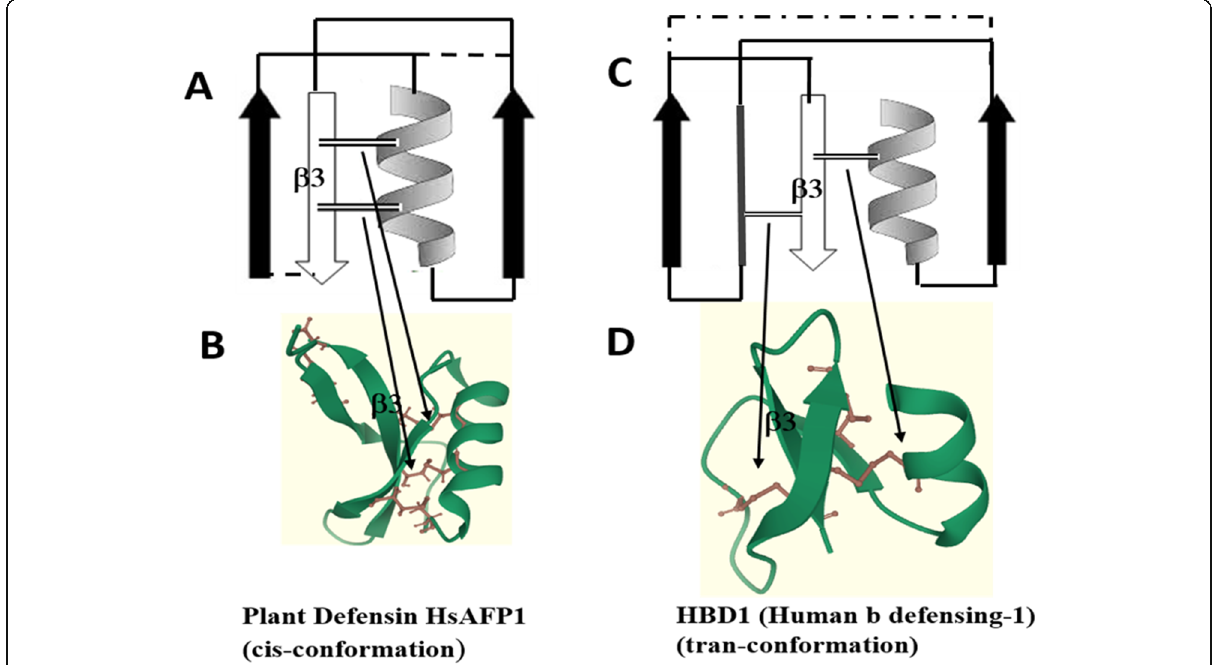
Fig. 2 Representative cis and trans conformation and corresponding tertiary structure of plant defensin HsAFP1 (cis) and human defensin HBD1 (trans). ( a and b ) Representative and tertiary structure of HsAFP1 (cis) and ( c and d ). For HBD1 (trans). In cis representative structure of HsAFP1, two consecutive conserved disulfides formed between a-helix and b-3 strand whereas in trans, these two conserved disulfide link form between a-helix and b-3 and b-3 and other secondary structure. --dash line placed between different secondary structure represent non-conserved disulfide